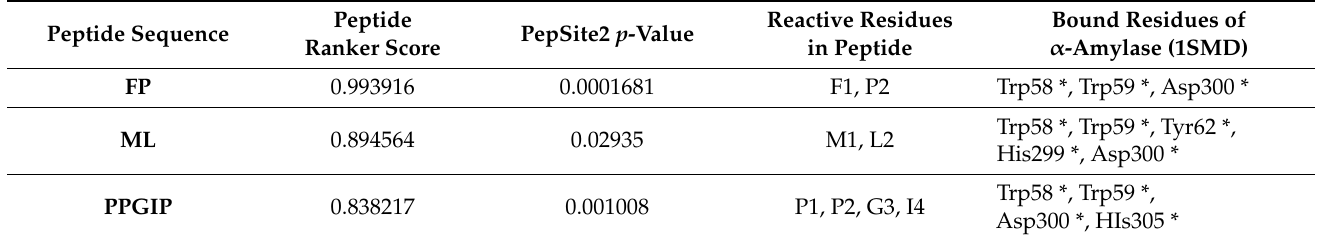
Table 5. Biologically active peptides from a selected lupin protein hydrolysate (FCT) and their binding potential with α -amylase (1SMD) as a protein